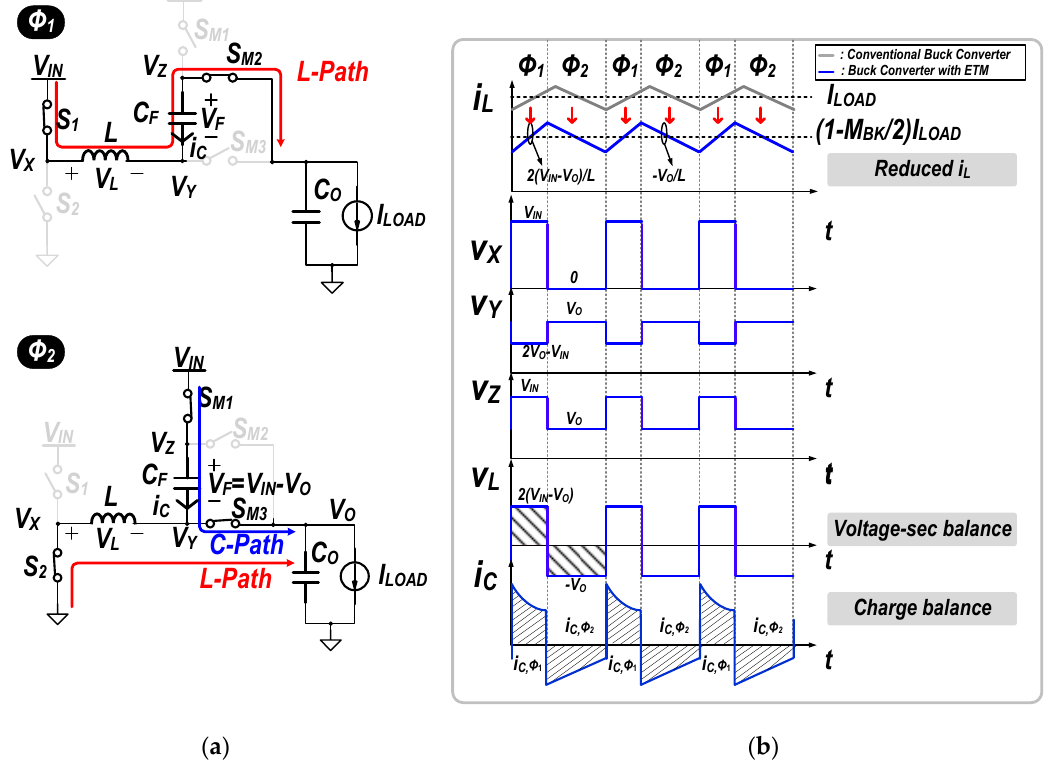
Figure6. Operatingmode( a )andwaveforms( b )ofbuckconverterwithenergytransfermedia(BKETM). Figure 6. Operating mode ( a ) and waveforms ( b ) of buck converter with energy transfer media (BKETM). In Φ 1 , S 1 and S M2 are turned on, and S 2 , S M1 , and S M3 are turned o ff . At this time, i L is built up In Φ 1 , S 1 and S M2 are turned on, and S 2 , S M1 , and S M3 are turned off. At this time, i L is built up with a slope of 2( V IN − V O ) / L and is delivered to the output. In Φ 2 , S 2 , S M1 , and S M3 are turned